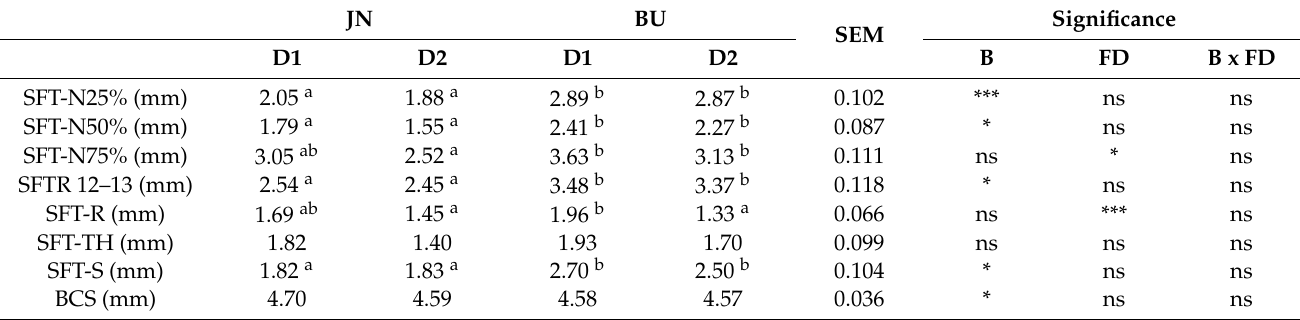
Table 4. Effect of breed and finishing subcutaneous fat thickness (SFT) and body condition scores (BCS) measurements in different anatomic sites from Jaca Navarra (JN) and Burguete (BU) foals. JN BU Significance SEM D1 D2 D1 D2 B B x